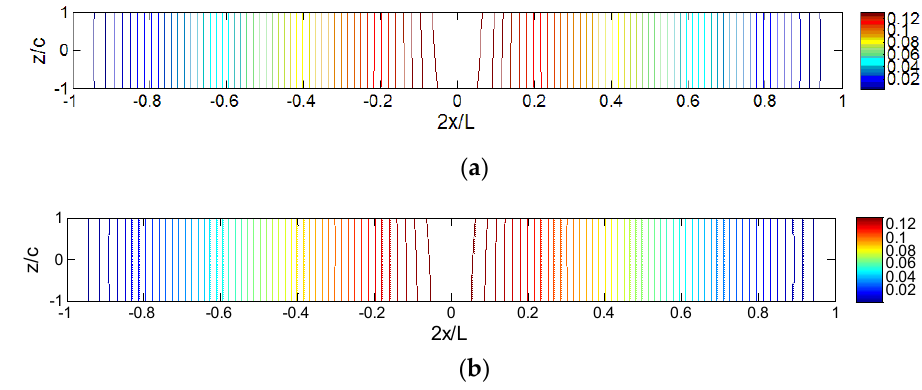
w w ) diagram for sandwich panels under locally Figure 4. Comparisons of iso ‐ displacement ( / n Figure 4. Comparisons of iso-displacement ( w / w n ) diagram for sandwich panels under locally distributed loads ( L p = 0.1 L ): ( a ) HDQM; and ( b ) ABAQUS. distributed loads ( L p = 0.1 L ): ( a ) HDQM; and ( b )